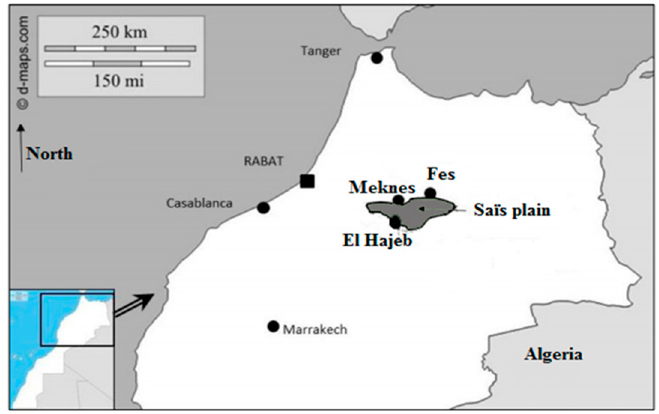
Figure 1. Location of the “Saïss plain” study area (Source: Baccar, 2017).